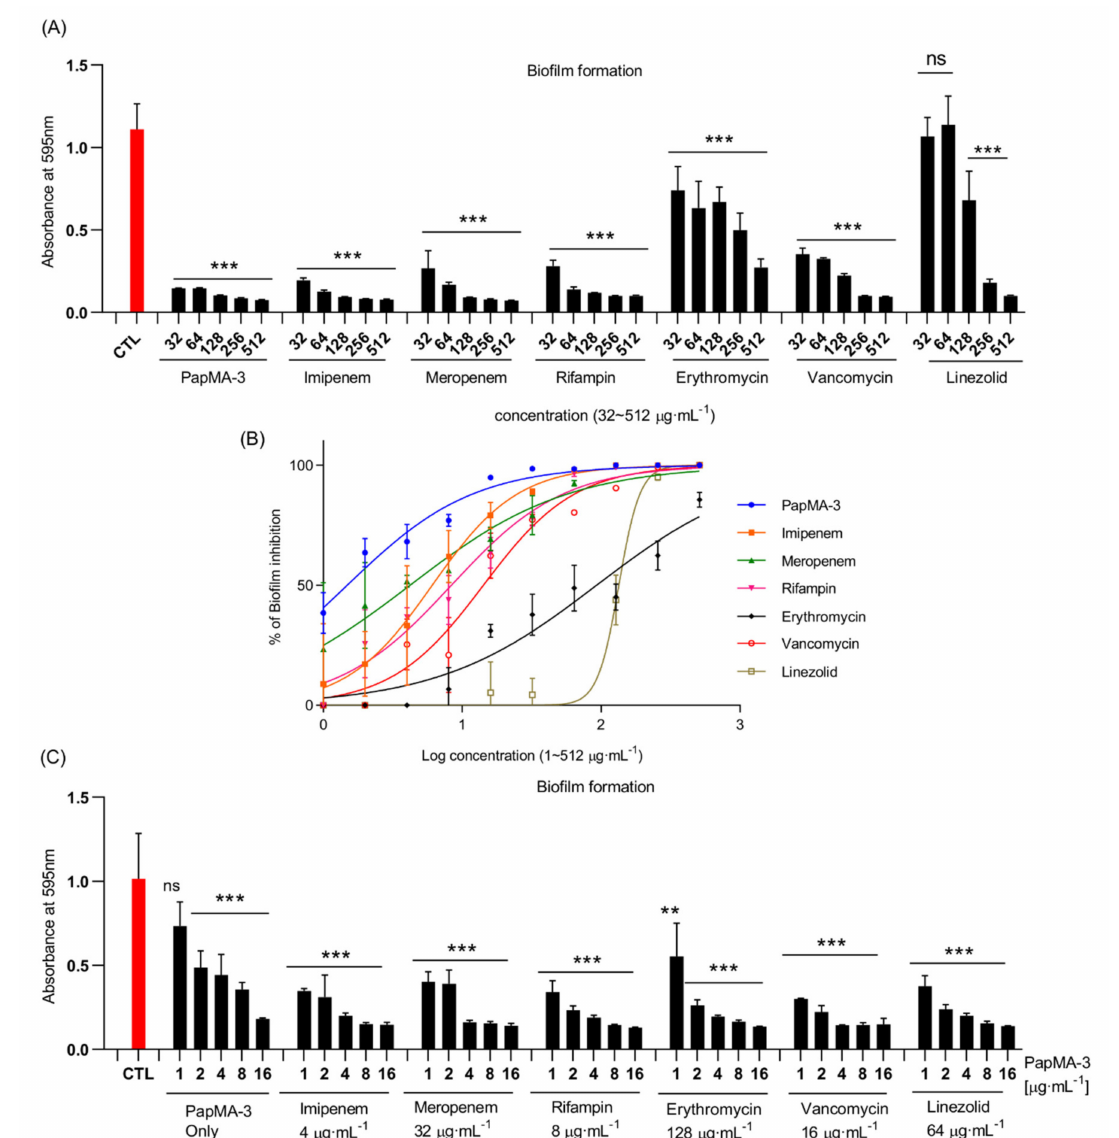
Figure 9. Anti-biofilm activity of PapMA-3 in combination with antibiotics. Biofilms were quantified by staining with crystal violet. ( A ) Absorbance of crystal violet-stained biofilms with treatment of PapMA-3 and antibiotics at a concentration range of 32 to 512 µ g · mL − 1 , assessed at 595 nm. ( B ) Confirmation of anti-biofilm activity against CRAB C1 at log scale concentrations (from 1 to 512 µ g · mL − 1 ) of PapMA-3 and antibiotics, comparative calculation result with CTL of 0% without peptide or antibiotics. ( C ) Synergistic anti-biofilm activities of PapMA-3 and antibiotics against CRAB C1, assessed based on absorbance at 595 nm. CRAB C1 without peptides or antibiotics served as the control (red). Statistical analysis was performed using two-way ANOVA with Dunnett’s comparison test. The values are expressed as the mean ± SEM of three independent experiments and are statistically significant at ** p < 0.01 and *** p < 0.001. ns, not